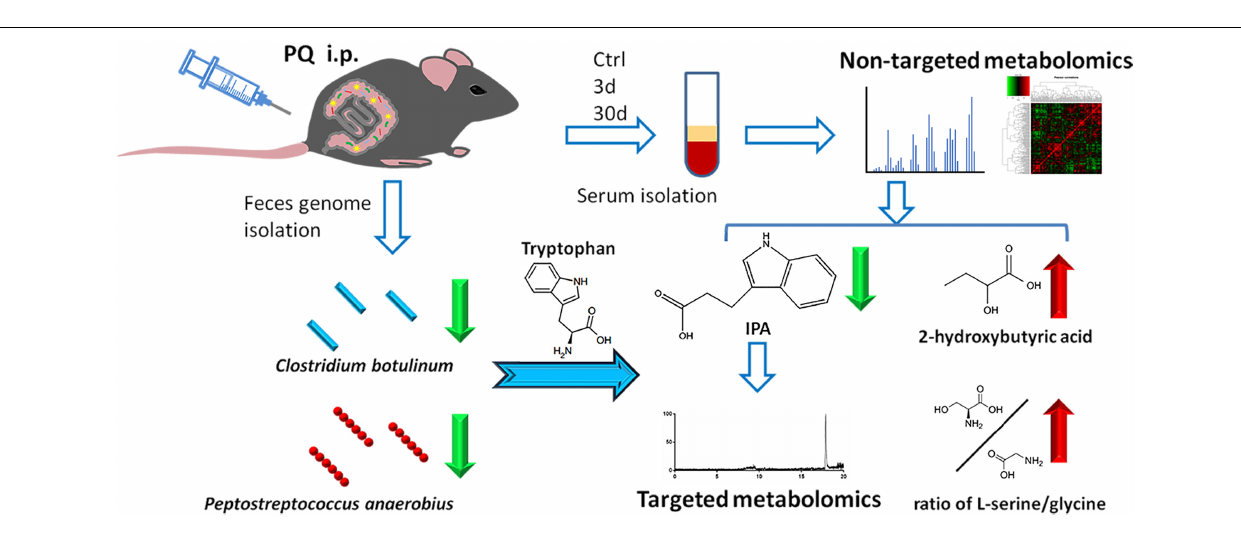
FIGURE 6 | Work flow of the presented